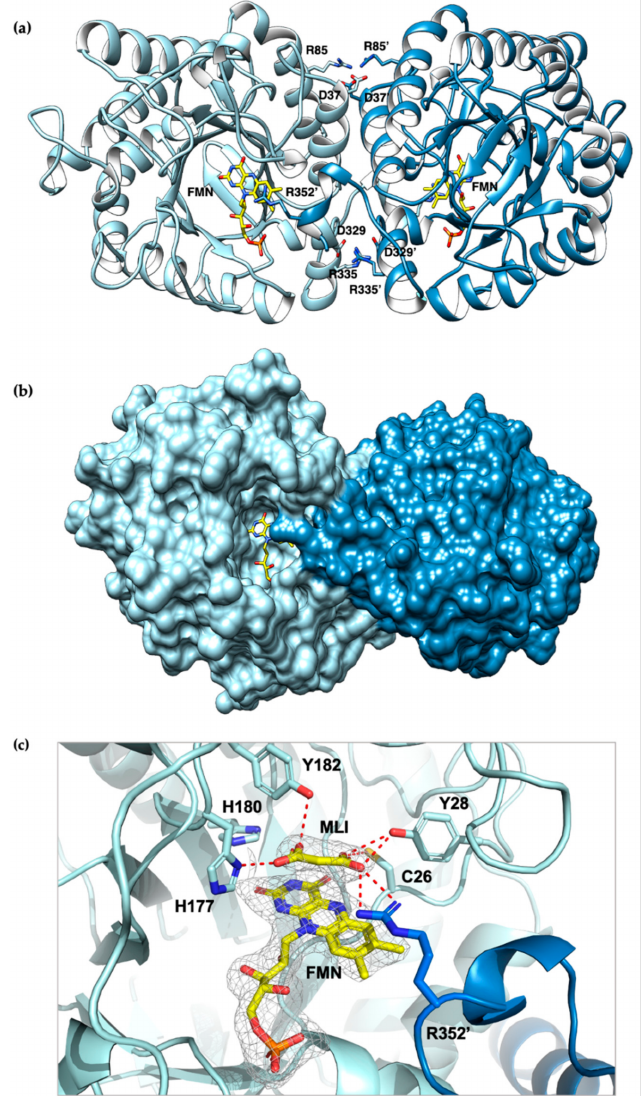
Figure 3. Cartoon representation of the crystal structure of Ca OYE (PDB 7O0T): ( a ) ribbon diagram showing the interactions involved in the dimer interface formation, ( b ) surface representation ( c ) details of Ca OYE active site: ligands omit map (FMN and malonate), for which the ligand residues had been omitted, has been calculated by Phenix and is shown contoured at 3 σ . The two monomers of Ca OYE are colored in light blue and steel blue; FMN cofactor and malonate (MLI) bound in the active site are shown with C atoms in yellow; most relevant residues of the catalytic cavity are shown with light blue C atoms, red O and blue N. Hydrogen bonds are shown as red dashed